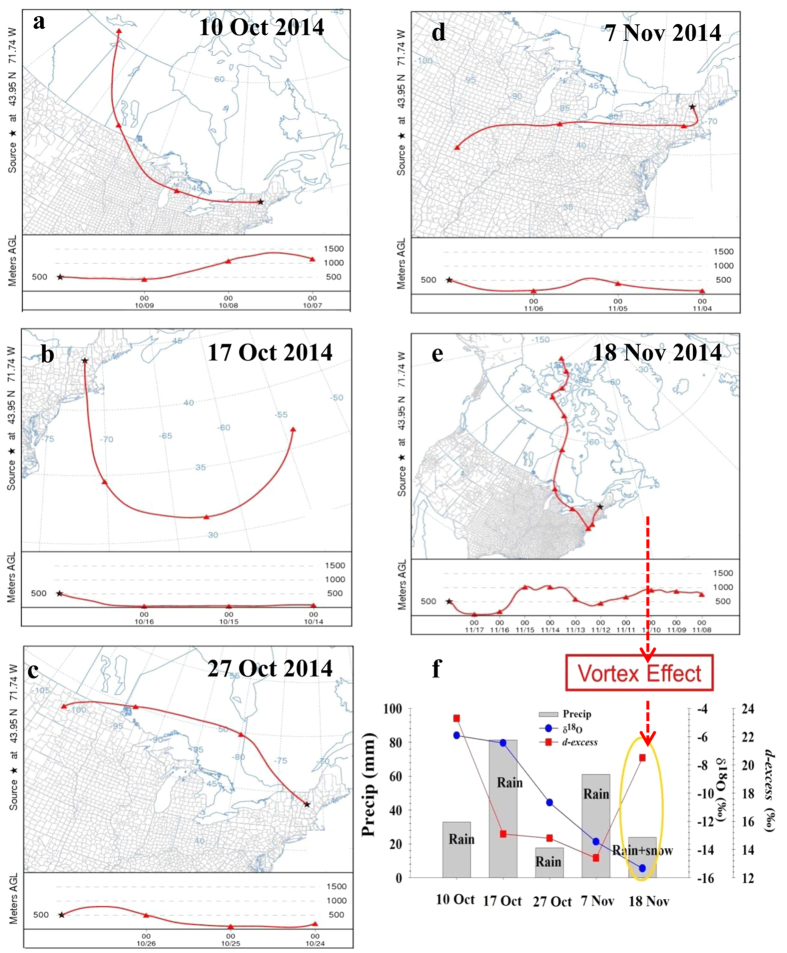
Polar vortex event in fall of 2014.Weekly sample results are shown in graph (f) with air parcel 72-hour back trajectories (a–e). The date on x axis of the graph (f) associated with selected trajectories are presented in a-e. The maps: output of the public website service software HYSPLIT40, https://www.ready.noaa.gov/HYSPLIT_traj.php and http://journals.ametsoc.org/doi/abs/10.1175/BAMS-D-14-00110.1.